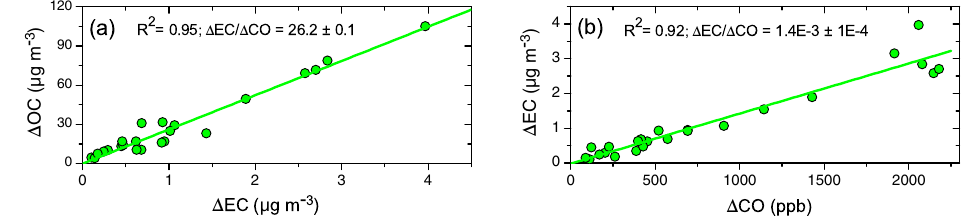
Figure 8. Scatter plot and linear regression of (cid:49) EC – (cid:49) OC (a) and (cid:49) CO – (cid:49) EC (b) during biomass burning episodes in the summer season (Table 2). The (cid:49) EC /(cid:49) CO slope is in µgm − 3 ppb − 1 .